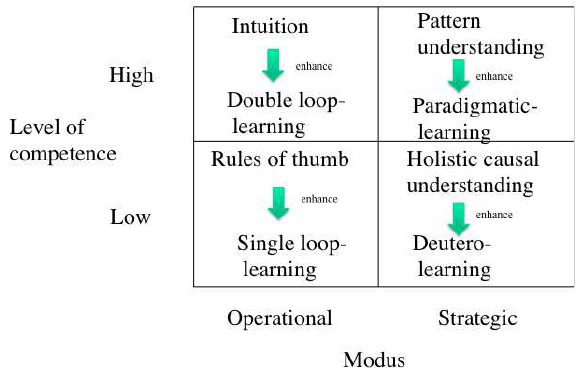
Fig. 1. Typology of tacit knowledge linked to organizational